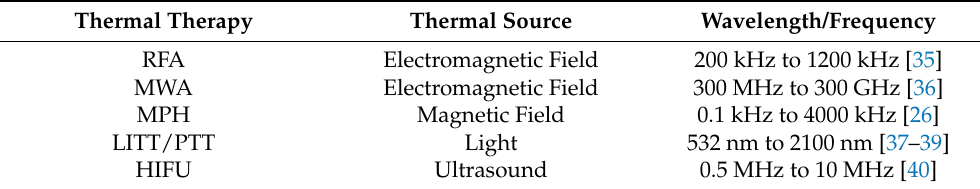
Table 1. The range of wavelength/frequency applied in several different thermal